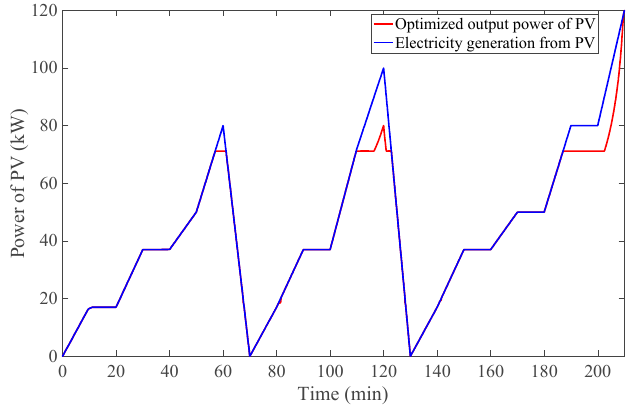
Figure 14. Output Power of the optimized solar system.